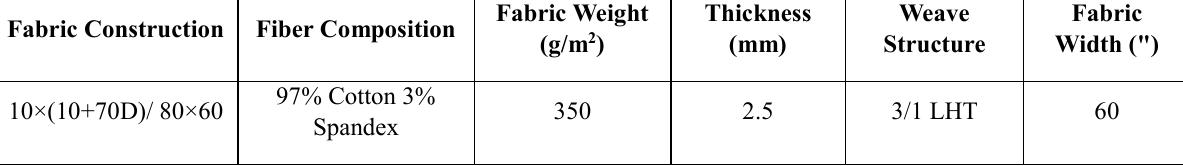
Cotton Spandex Woven Fabrics used in this Experiments. Fabric